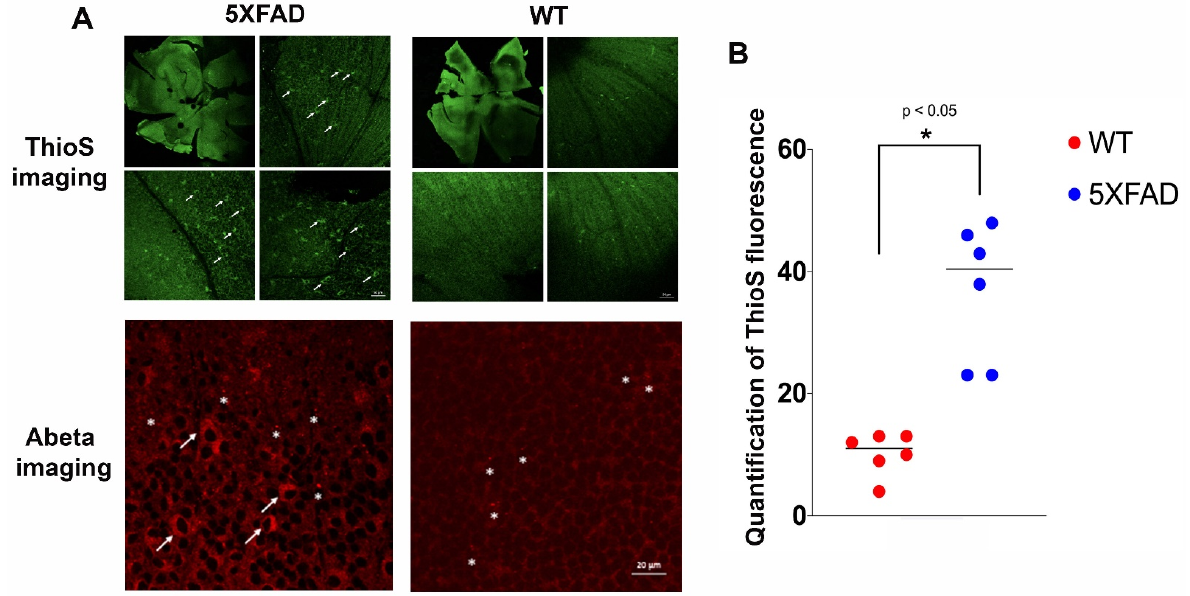
Figure 2. Representative images of confocal fluorescence imaging of retinal whole-mount of treated wild type (WT) versus 5XFAD mice. ( A ) ThioS fluorescence (green, 488 nm channel) are prominent in different areas of the 5XFAD retinae compared to those from WT counterparts. There are some signals in the WT retinae, although much less, but detectable. Selected areas are magnified to show more detailed information. The fluorescence signal appears in the intracellular compartment of the retinal ganglion cells (RGC, arrows). These results corroborate with the retinal amyloid beta (Abeta) immunohistochemistry (red, 546 nm channel) shown in the bottom panels in which RGCs are labeled in 5XFAD (arrows) and extracellular Abeta deposits are also present (asterisks) in both 5XFAD and WT mice; ( B ) quantification of the ThioS signal was performed on retinal sections from WT and 5XFAD mice, and the signal distribution was scored on an ordinal scale after thresholding using Otsu method, and presented in the vertical scatterplot. An asterisk indicates significant differences between WT vs. 5XFAD ( p < 0.05).